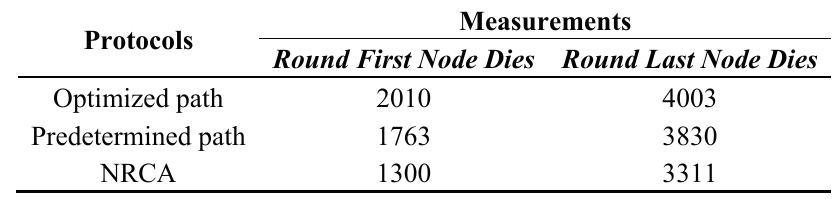
Table 2. Simulation results for the network lifetime based on Figure 1a.